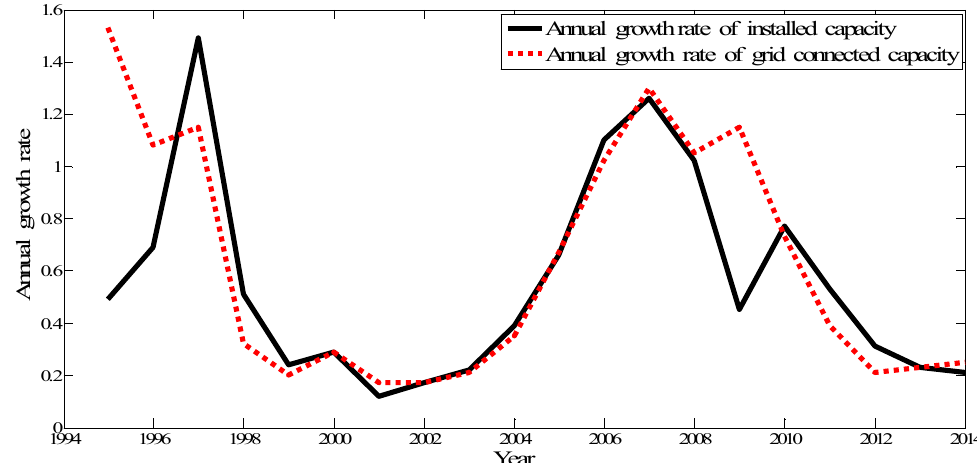
Figure 3. Relationship between the growth rate of installed capacity and the growth rate of grid-connected capacity.